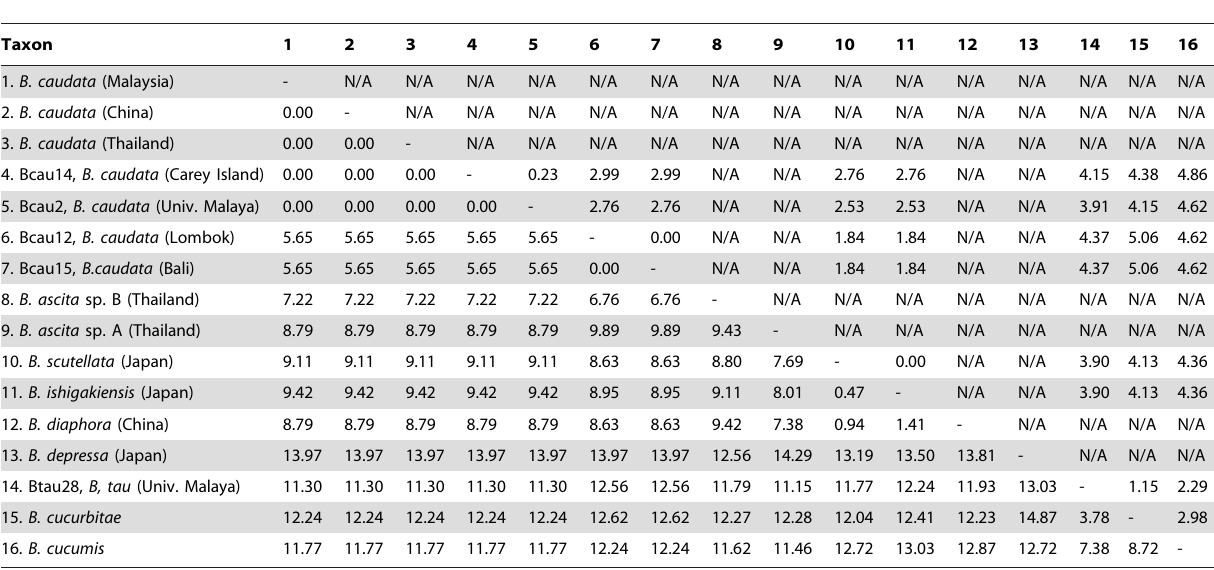
Table 1. Percentage of uncorrected ‘‘p’’ distance matrix between Bactrocera caudata and related species based on 16S (above diagonal) and COI (below diagonal) DNA sequences.